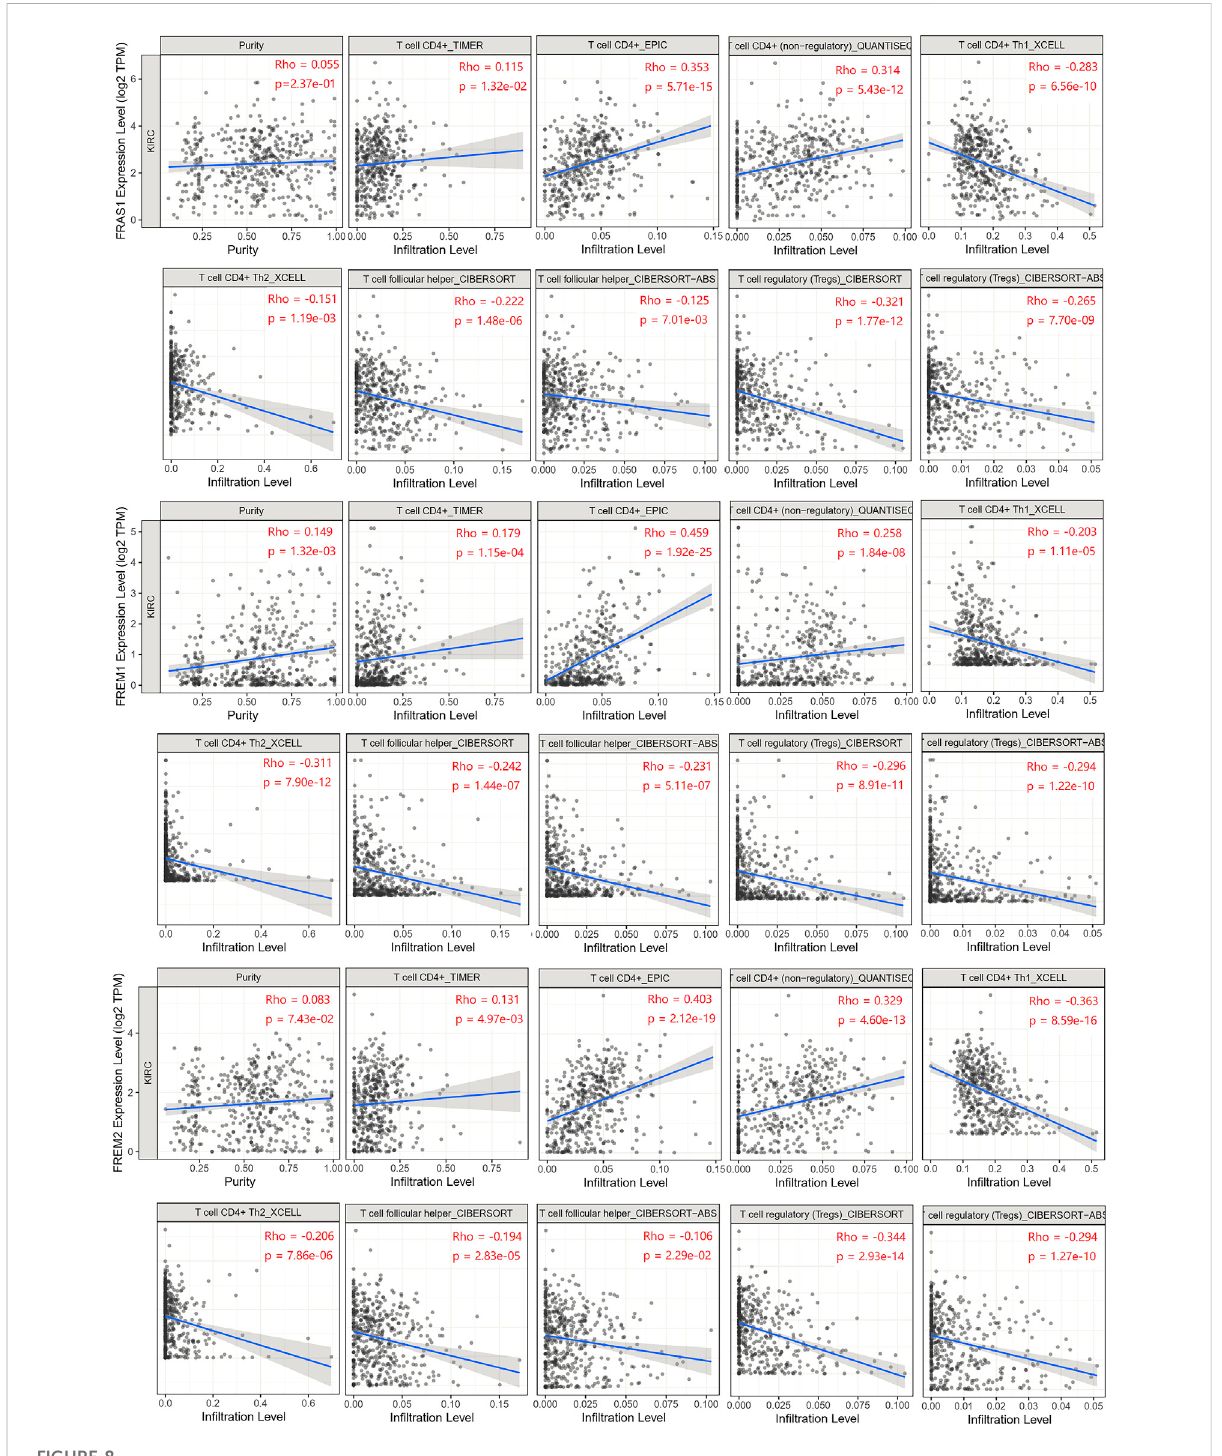
FIGURE 8 Relationship between FRAS1/FREM expression and CD4 + T cells, its corresponding subsets (Th1, Th2, Tfh, and Tregs) in